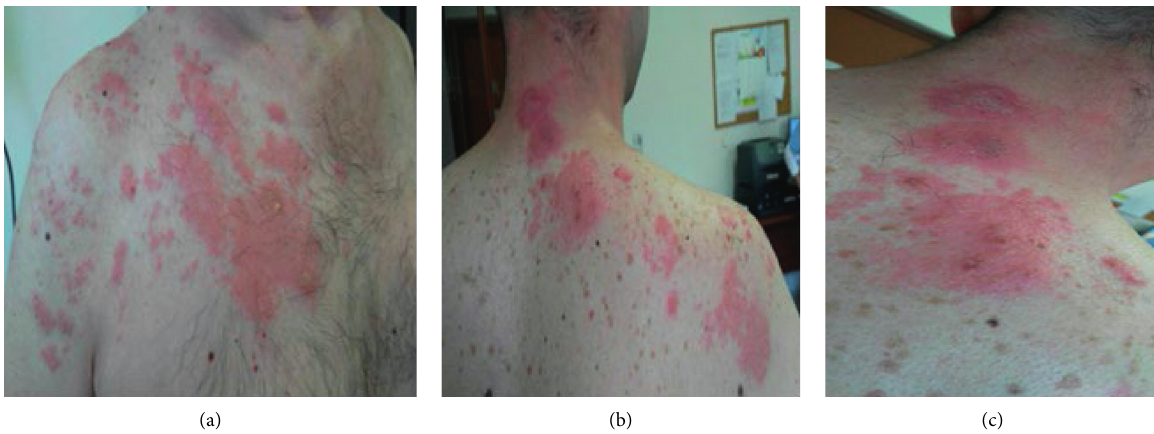
Figure 2: (a)–(c) Maculopapular lesions at different angles of herpes zoster. The three photos were taken on the same day. All stages of HZ can be seen: erythema, pustules, and crusts on the right thoracic region with dermatome C5, C6, C7, C8, and T1.